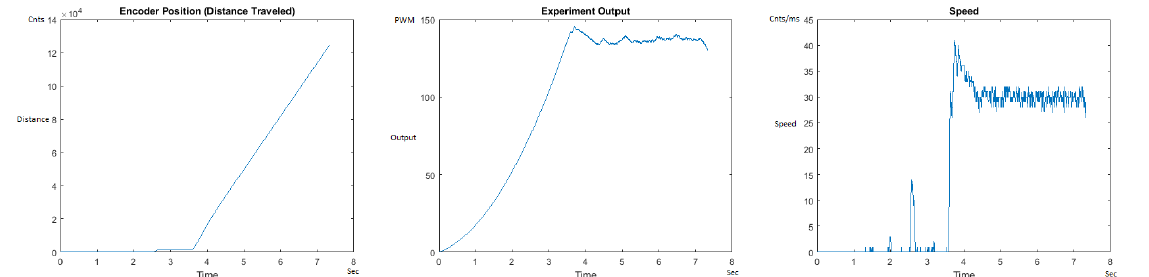
Figure 18. Encoder position, output and speed plots for PID++ UP operation— Vmax 30 cnts/ms, Adesired 0.015 cnts/ms 2 — 1 Kg.